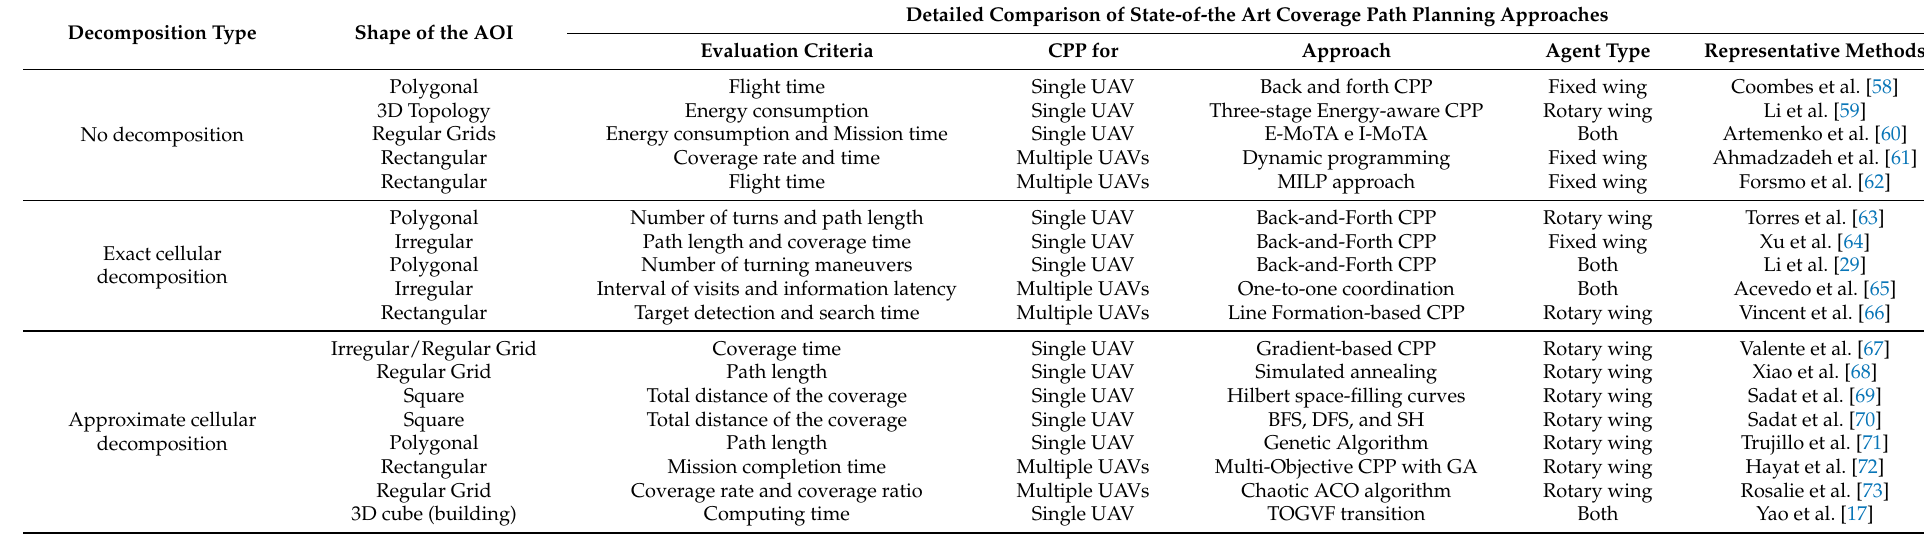
Table 1. Description of the state-of-the art coverage path planning approaches used in single AOI